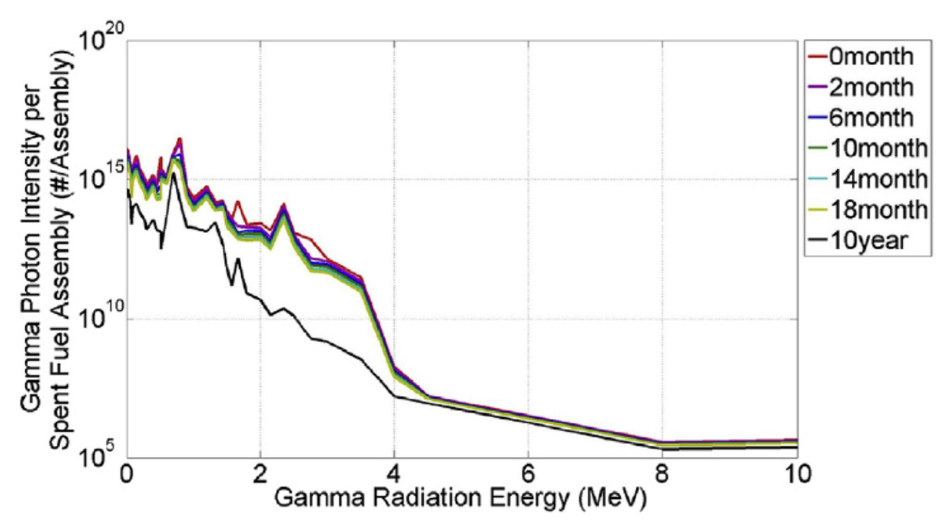
Figure 6. The energy distribution of gamma radiation generated by a single spent fuel assembly. Reproduced with permission from [121].